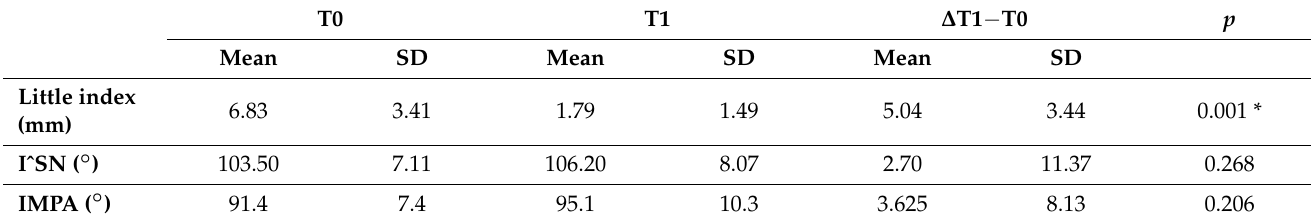
Table 2. Digital cast and cephalometric analysis before (T0) and at the end (T1) of the orthodontic